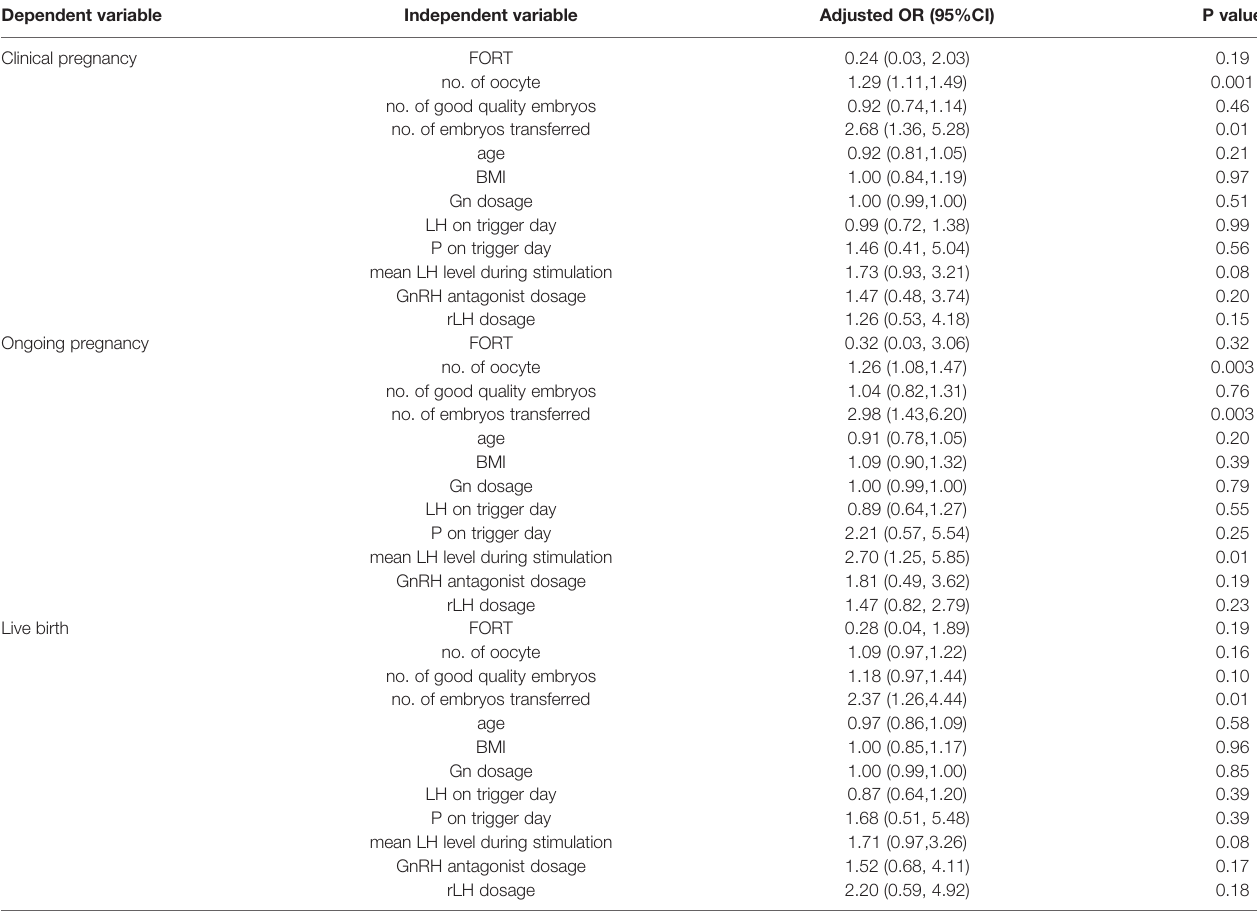
TABLE 4 | Multivariate regression results for reproductive outcomes: patients in the GnRH antagonist protocol arm.